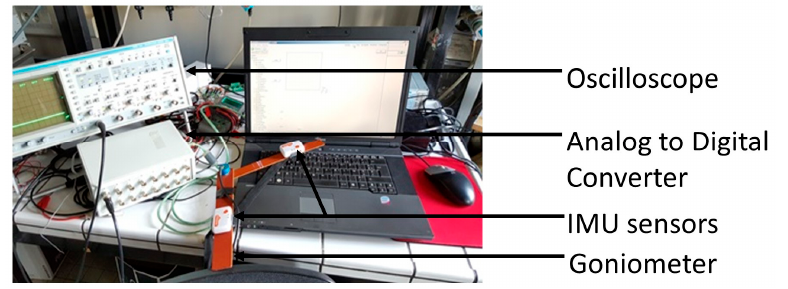
Figure 3. Goniometer protocol set-up for testing.